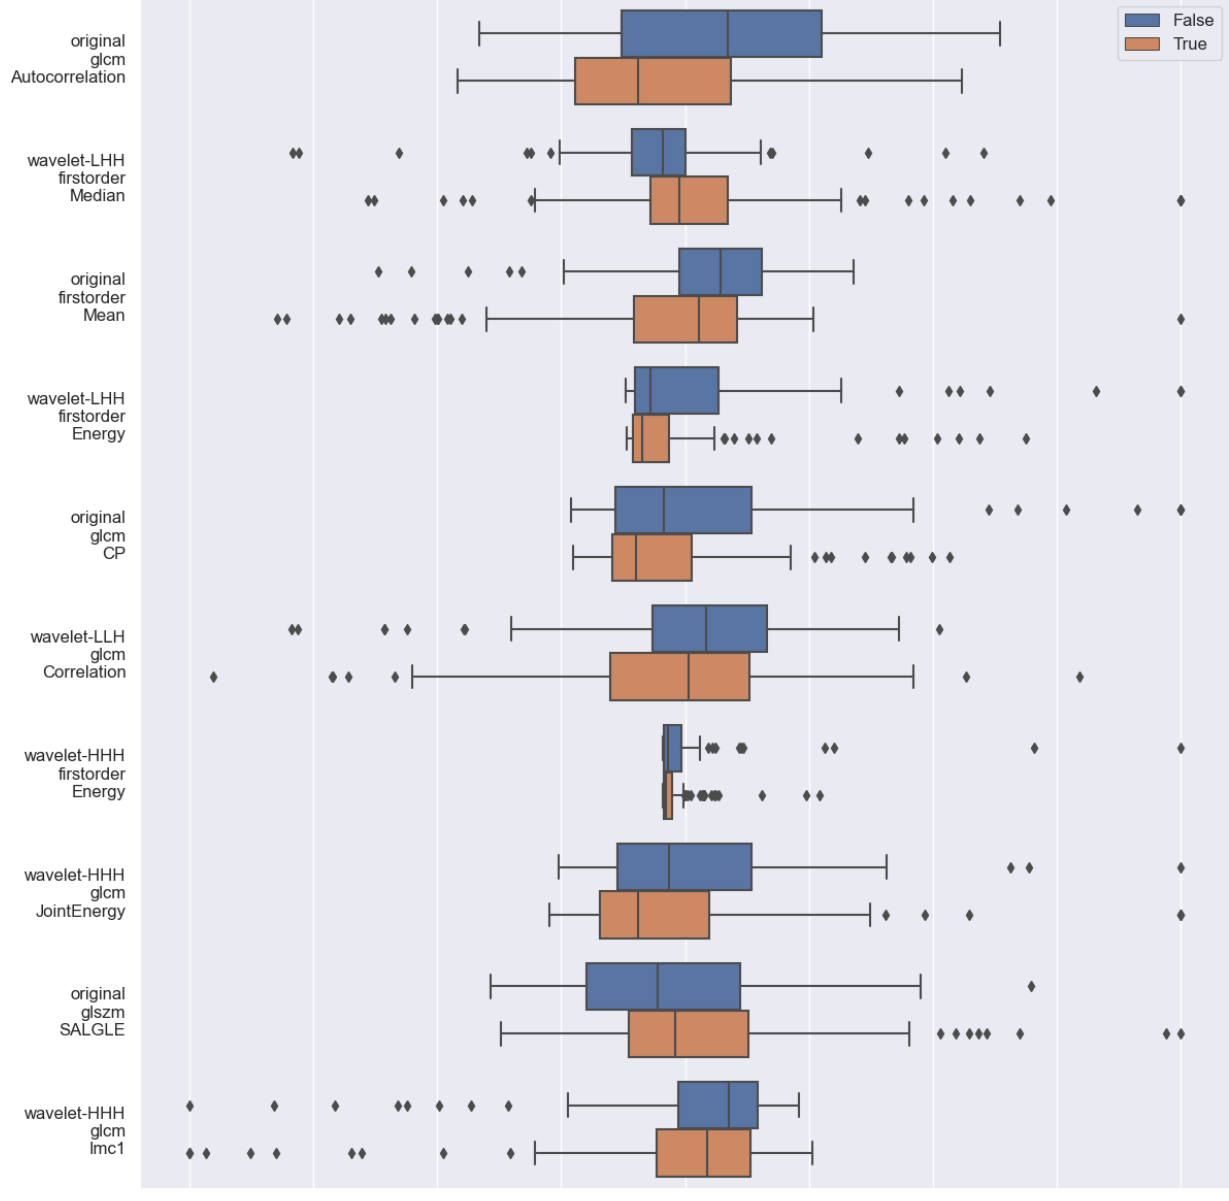
Figure 5. Box plots of the selected features. Feature distributions are shown on the data from D1 images. Normalized values have been clipped in the range [ − 4,4 ] , to avoid that some outliers will after the nature of the boxplots. Features original_glcm_Autocorrelation , wavelet-LHH_firstorder_Median , and original_firstorder_Mean , have p -value < 0.05 in Mann– Whitney U test. The p -values are, respectively, 0.001, 0.004, and